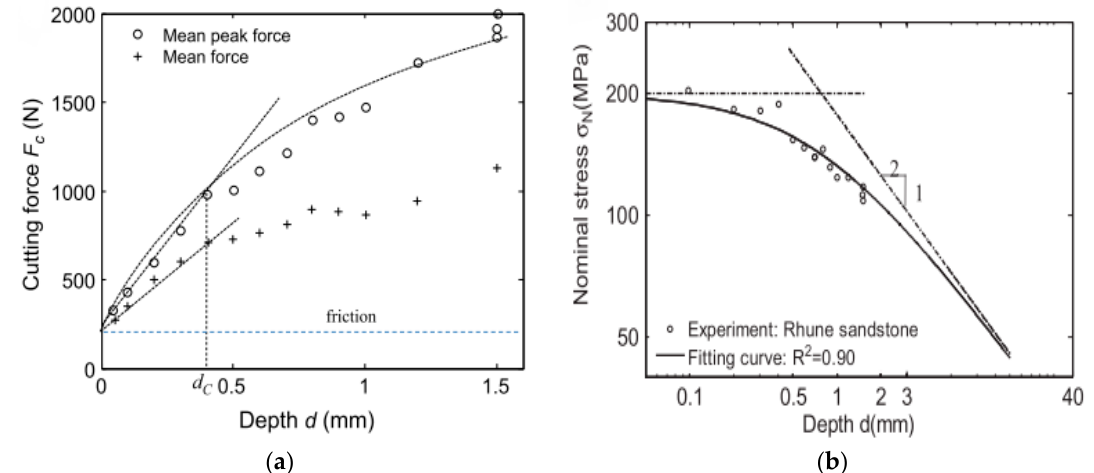
Figure 2. ( a ) The cutting force versus depth of cut (DOC) graph for Rhune sandstone [4]. The averaged peak shear load increases linearly up to the transition point. d c is the depth where the linearity ends. Here, the critical DOC is found at about 0.4 mm Rhune sandstone. ( b ) The nominal stress-DOC graph for Rhune sandstone [18]. Two dashed lines intersect at 0.8 mm, which is the critical DOC.